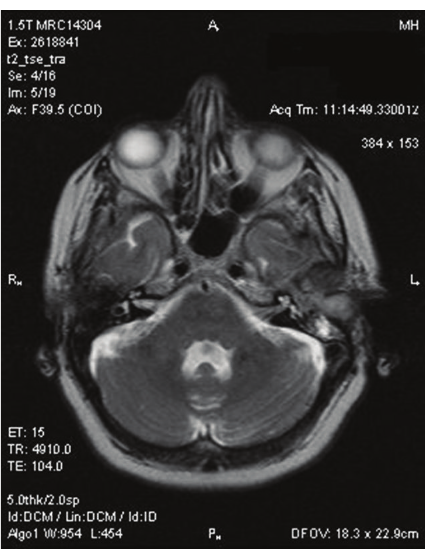
Figure1:AxialT2weightedMRIimagedemonstratingtheleftsided tumour